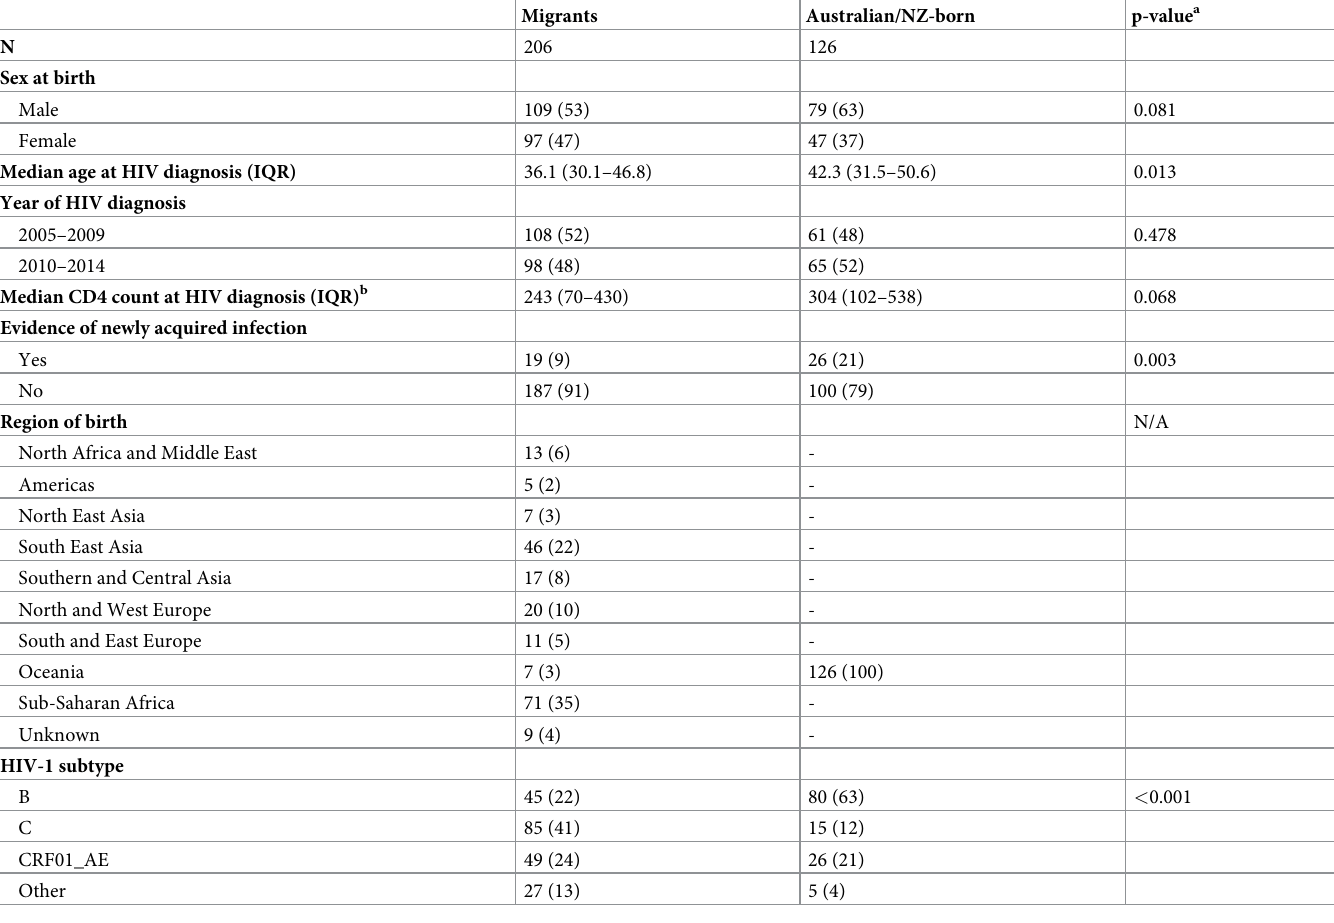
Table 1. Characteristics of 332 HIV notifications with heterosexual exposure category and pol sequences available,